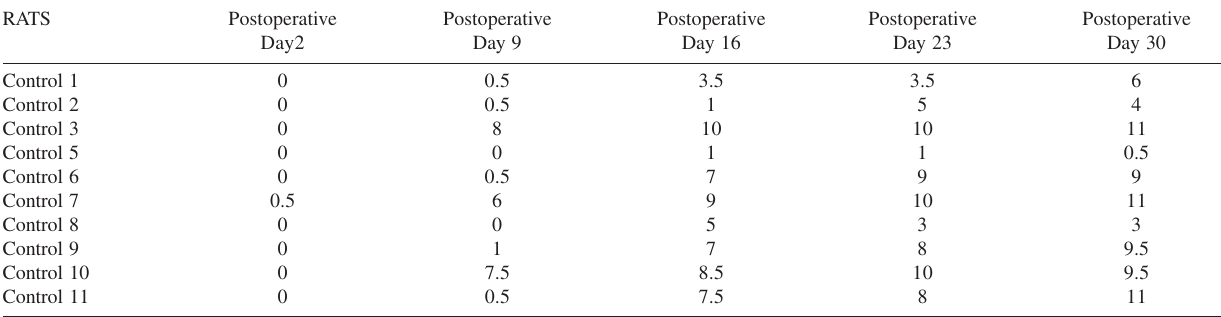
Table 3 - Functional evaluation, control group RATS